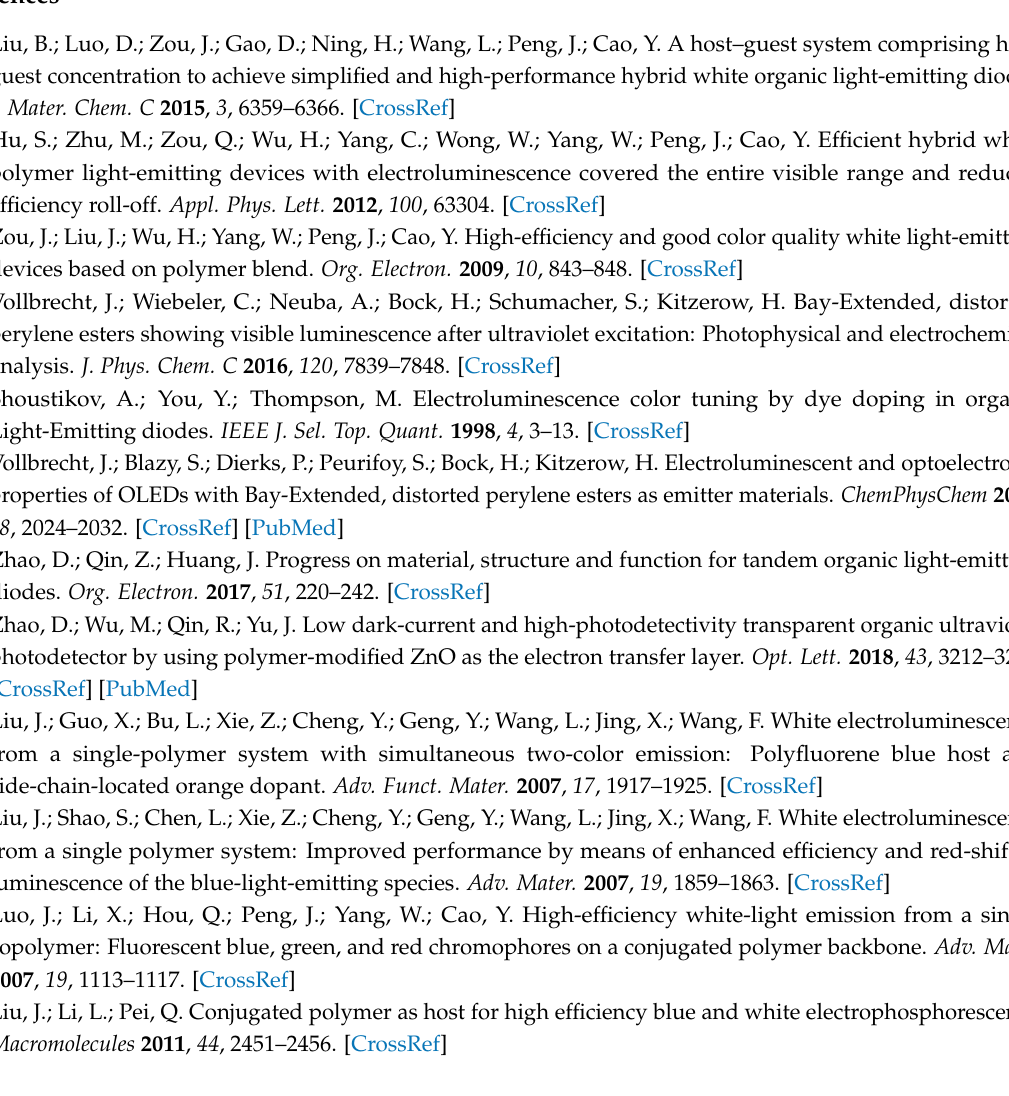
s1, Figure S1: The double-logarithmic JV curves, Figure S2: The 1931 CIE chromaticity diagram of emission of the WPLEDs; ( a ) the CIE coordinates of devices A1–A4 at a voltage of 10 V; ( b ) the CIE chromaticity diagram of device A2 at different voltages, Figure S3: The fit curves of the time-resolved PL for copolymers P1-P4; ( a ) the white-light copolymer in solutions; ( b ) the white-light copolymer in